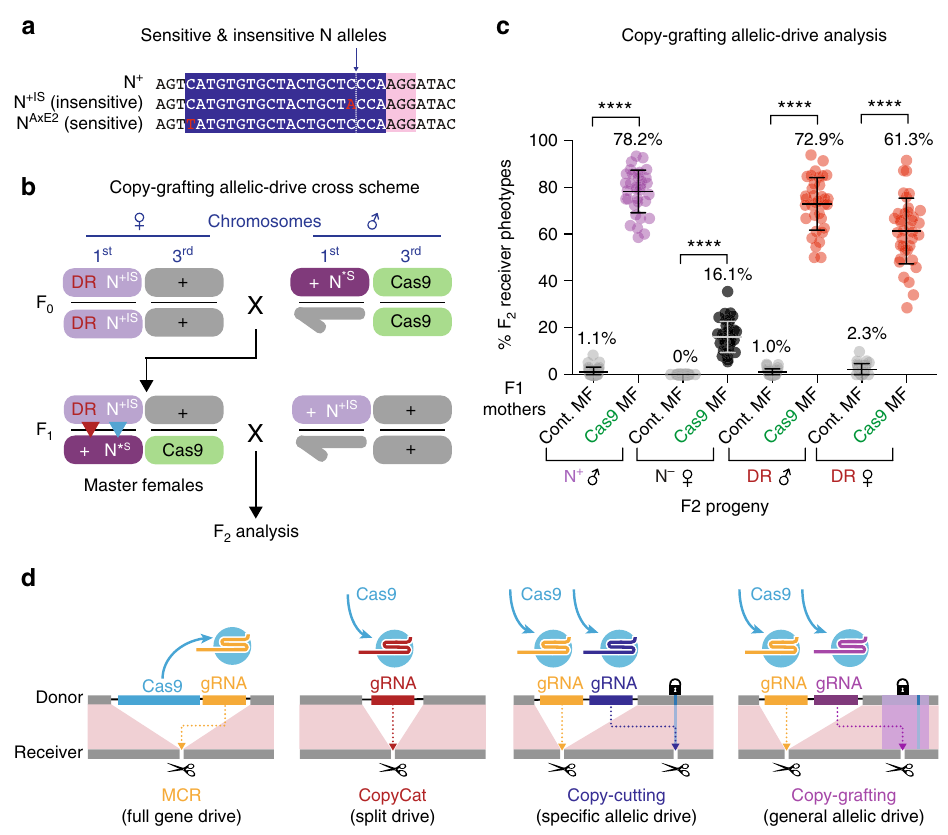
Fig. 4 Allelic-drive mediated by “ copy-grafting. ” a DNA sequence at the gRNA-N + cleavage site for the wild-type reference allele ( N + S ), the cleavage- insensitive wild-type ( N + IS ), and the cleavage-sensitive N AxE2 allele, with the C → T substitution (see Supplemental Fig. 6 for amino acid substitutions). b Copy-grafting scheme in which F1 master females carrying a wild-type cleavage insensitive wild-type Notch allele in trans to the sensitive N AxE2 allele (N* S ) ( y <ccN> w a N + IS / y + w + N AxE2 ; Cas9/ + ♀ ) are crossed to N + IS ♂ . F2 progeny were then scored based on inheritance of the y <ccN> w a N + IS donor chromosome (light purple) or the w + receiver chromosome (dark purple) based on their eye color phenotype (orange for donor and red for receiver). Red and blue arrowheads indicate copying of the y <ccN> element and the N + IS allele, respectively. c Percentage of F2 progeny demonstrating features of drive including: percentage of converted N + IS receiver chromosomes (purple circles); heterozygous N − / + females (black circles); and copying of the DsRed marked y <ccN> element to receiver chromosome (red circles). d Summary of different drive systems. MCR (full gene drive) elements have both Cas9 (blue) and a gRNA (yellow) inserted into the genome at the gRNA-directed cleavage site. CopyCat (split drive) elements carry only the gRNA (red) inserted at the gRNA-directed cleavage site, while Cas9 is provided from a Mendelian transgene at a different genomic location. Copy-cutting (special allelic-drive) is mediated by two gRNAs. One gRNA (yellow) propagates the CopyCat element while the second gRNA creating allelic-drive (dark blue) cuts a non-preferred allele, but not the favored allele (lock icon). This drive element could be either an MCR (including Cas9) or a CopyCat element (Cas9 provided from a separate genomic location, as depicted in this fi gure). Copy-grafting (general allelic-drive) is mediated by a gRNA (purple) that cuts the non-preferred, but not the favored, chromosome near the desired allelic variant, resulting in conversion of a short region of the receiving chromosome (indicated by purple highlight) with sequences from the donor chromosome (purple box) that encompass the favored allele (lock